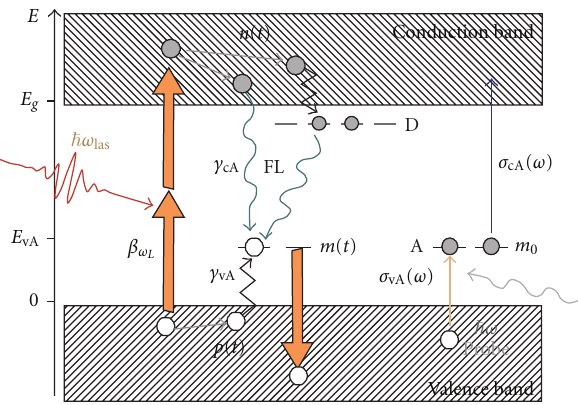
Figure 12: Scheme of the processes considered for the calculations of γ -DLSS dynamics and impurity